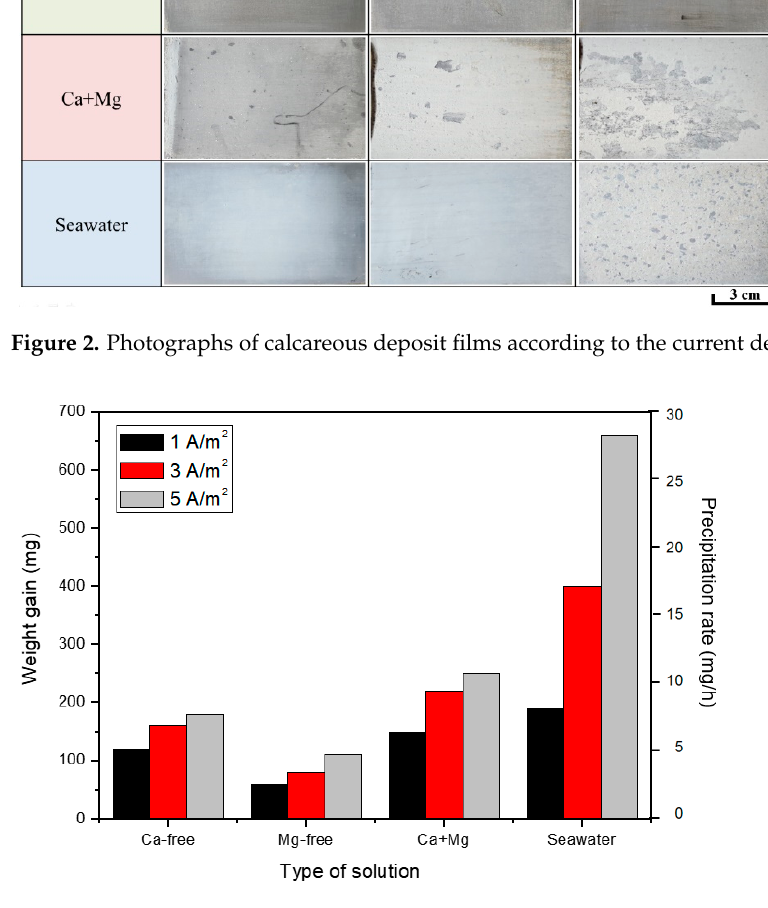
Figure 3. Variation of weight gain on calcareous deposit films in artificial seawater and natural seawater after 24 h.